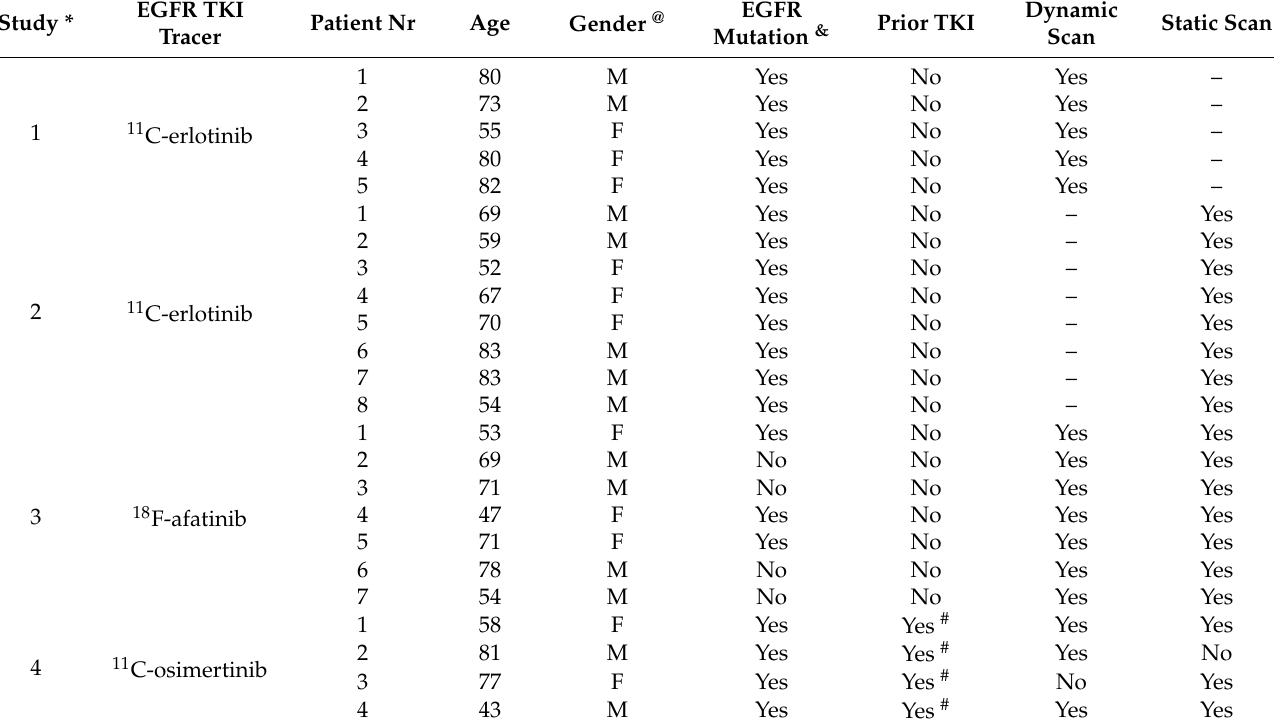
Table 1. Baseline